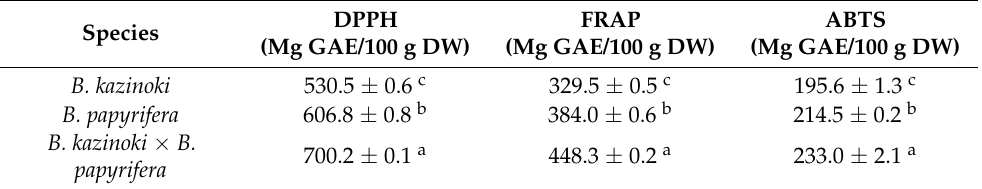
Table 2. Antioxidant activity of B. kazinoki , B. papyrifera and B. kazinoki × B. papyrifera leaves.